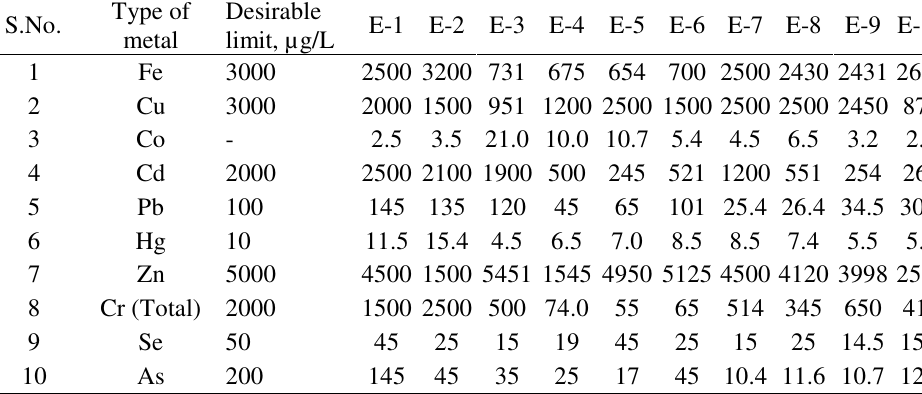
Table 2. The results of heavy metal determinations in effluent water sample.